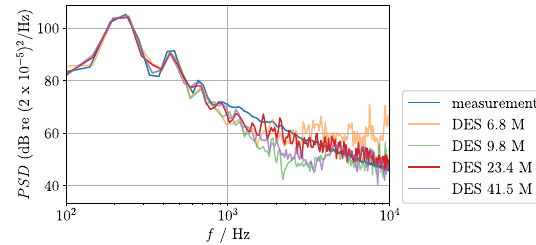
Figure 12. Power spectral density (PSD) dependent on cell number for pressure transducer 7 and a simulation and measurement time of 0.02 s.